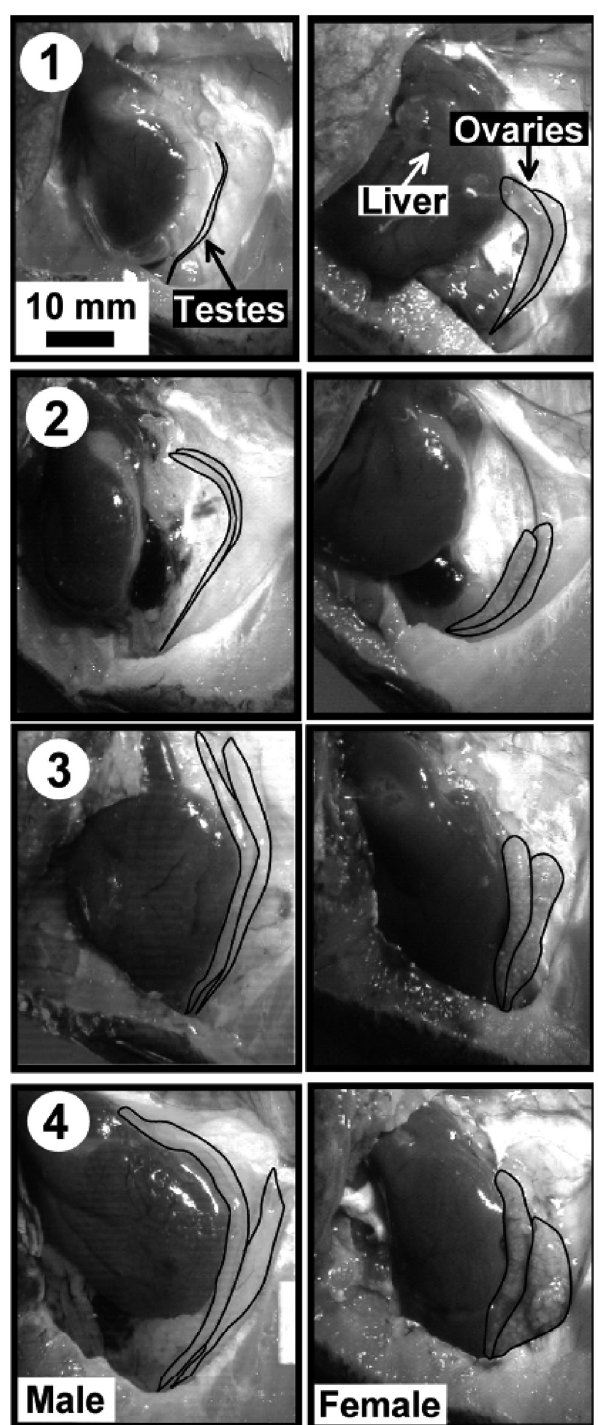
Fig. 4. (right column) Testes and ovaries of Symphysodon haraldi at advancing stages of gonadal development. Photographs are from freshly sacrificed and dissected specimens, with the gonads outlined for clarity. The following modified version of Nikolsky’s scale of reproductive maturity was utilized: 0. (immature): gonads thin and transparent; sex determination not possible (not illustrated). 1. (early development or resting): testes thin and translucent; ovaries thin and translucent-pink with transparent eggs. 2. (maturing): testes translucent white; ovaries enlarged with white eggs. 3. (mature): testes thick and white; ovaries enlarged with largest eggs yellow. 4. (pre-spawning): testes swollen and sperm-positor everted; ovaries swollen with largest eggs orange, swollen and approximately 1.4 mm in diameter, ovipositor everted. 5. (spent): testes flaccid; ovaries flac - cid with scattered eggs of various size classes (not